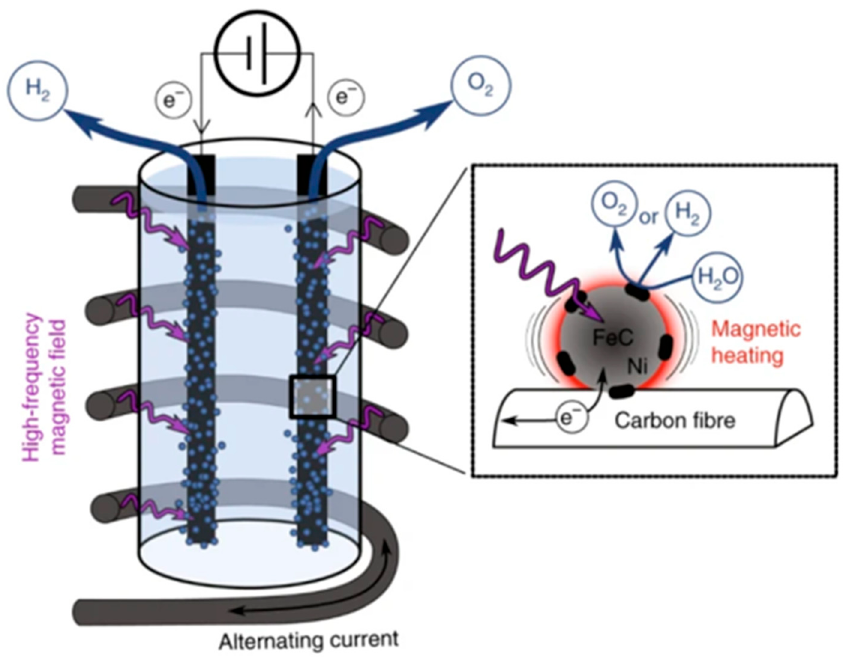
Figure 15. Application of magnetic heating in electrolysis of water for hydrogen production [88].